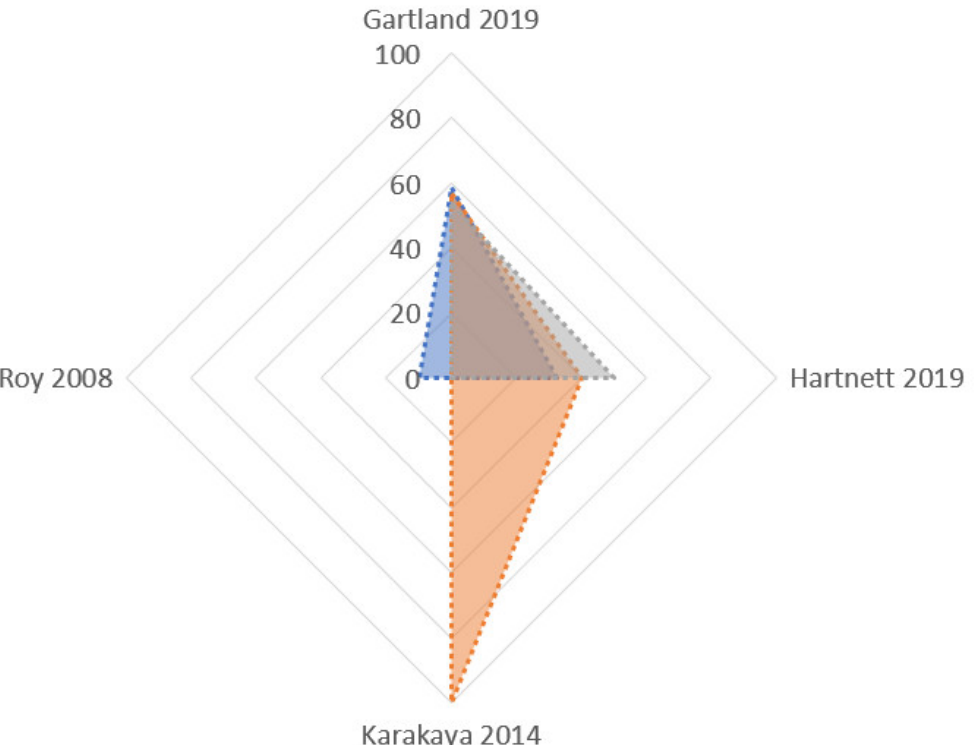
Figure 7. Radar chart: Defensive verdicts in litigations. The largest polygon (pink area) is the most common cause of defensive verdicts in litigations, that is, the improper post-operative management of the injury. The other two areas demonstrate incorrect presurgical assessment (grey area) and improper intraoperative surgical performance (blue area).